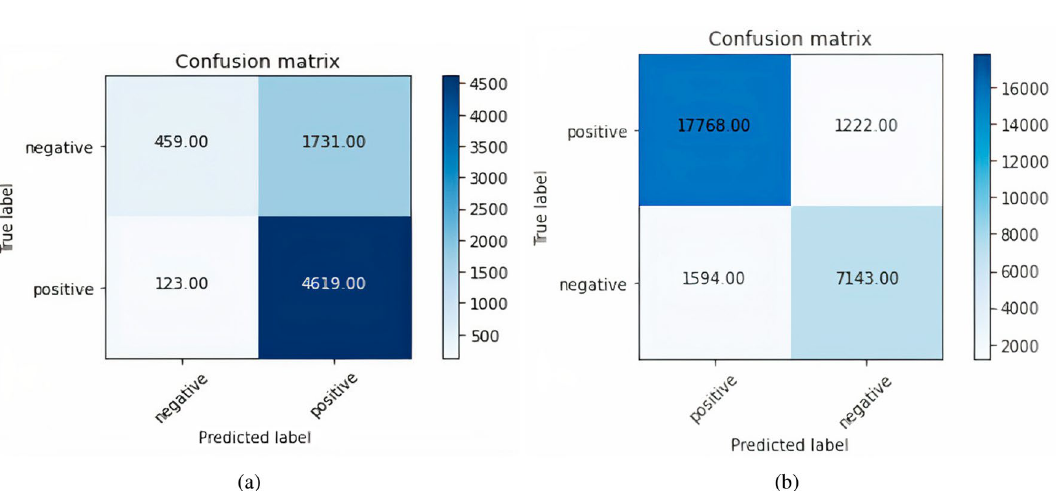
Figure 11. Glove plus Multi-channel CNN and RMDL ( a ) Confusion matrix Glove plus Multi-channel CNN; ( b ) Confusion matrix Glove plus